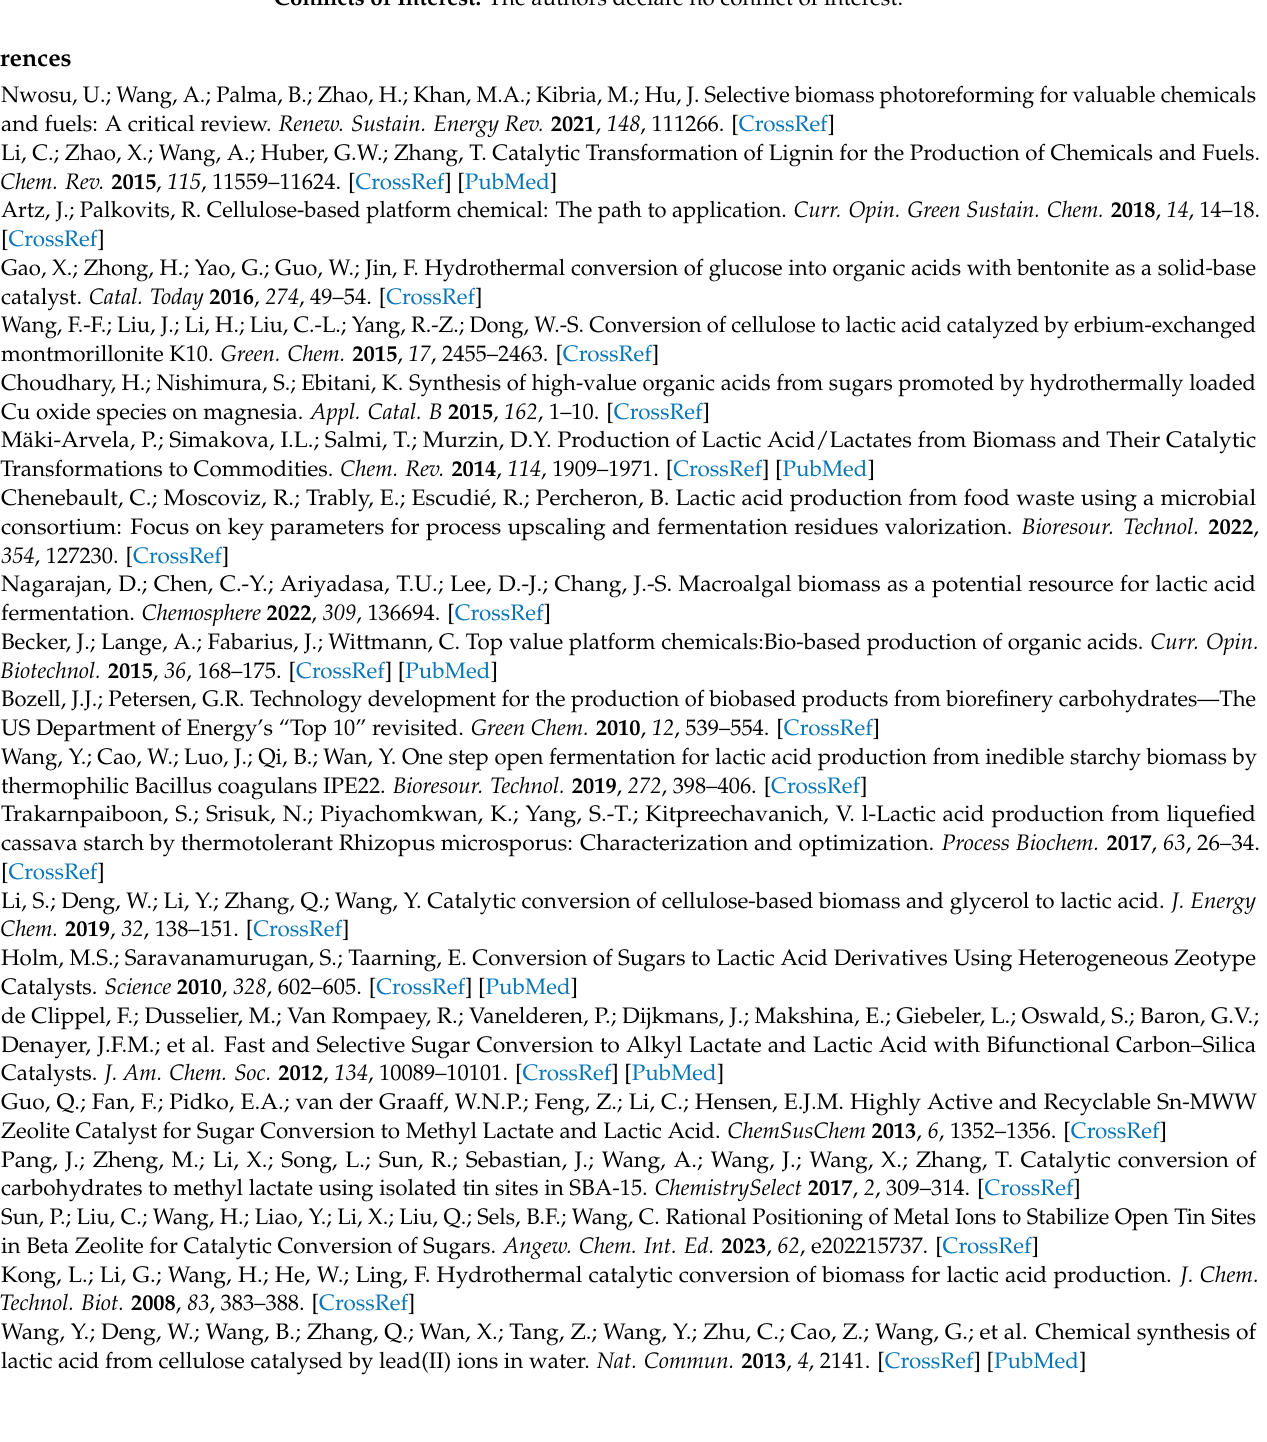
Figure S3. TEM and EDS images of the used 2RuO x /MoS 2 ; Figure S4. The survey spectra of fresh and used 2RuO x /MoS 2